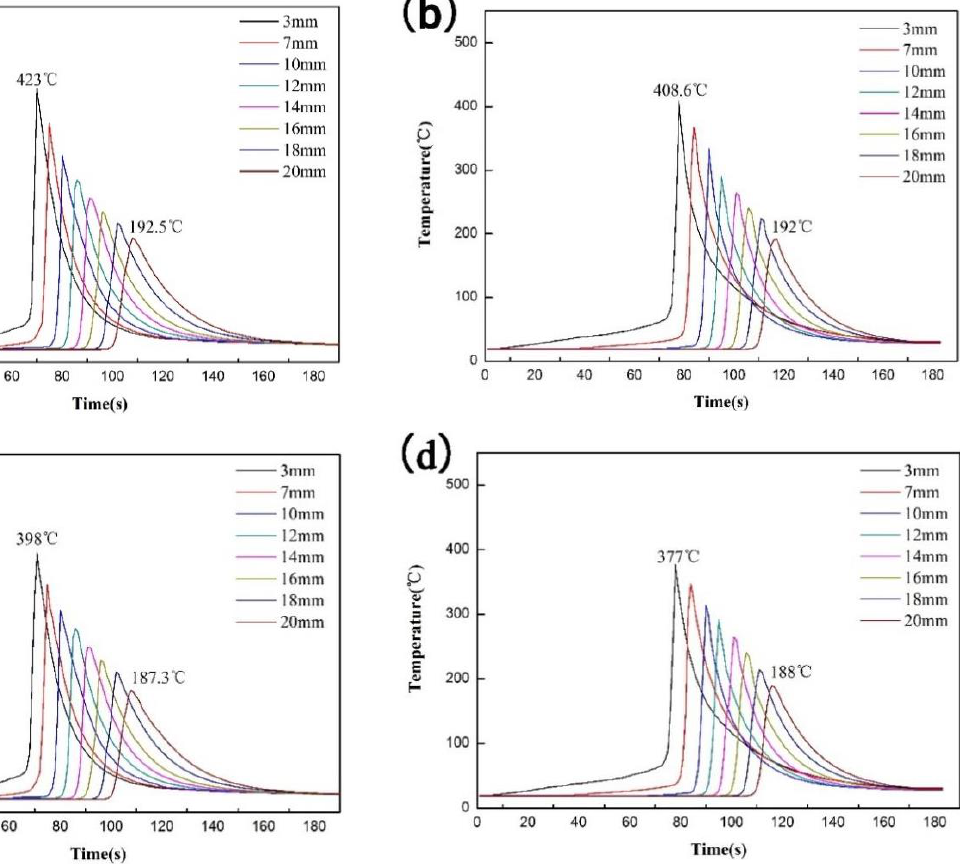
Figure 5. Welding thermal cycle curves of different tool pins. ( a ) AS of tool pin A; ( b ) RS of tool pin A; ( c ) AS of tool pin B; ( d ) RS of tool pin B; (e) AS of tool pin C; ( f ) RS of tool pin C. 3.2. Metal Migration of Weld Cross-Section Figure 6 shows the macroscopic characteristics of the weld cross-sections obtained using three different shapes of tool pin. We divided the macroscopic image of the welded joint into four areas: shoulder affect zone (SAZ), turbulent zone, TMAZ-AS and TMAZ- RS. The AS material was 2024-T6 Al alloy of light color and the RS material was 6061 Al alloy of dark color. The plasticized metal on the AS is directly affected by the tool pin, and the plasticized metal rotates with the tool pin and makes a ’ vortex ’ motion on the same layer. Because the ‘ vortex metal ’ interacts with a small amount of plasticized metal when